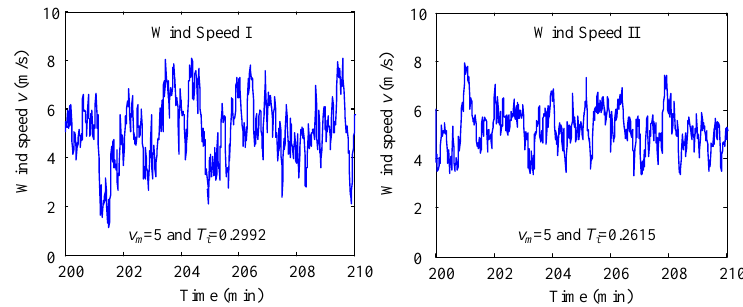
Figure 6. Wind speed profiles including wind speed I and wind speed II.